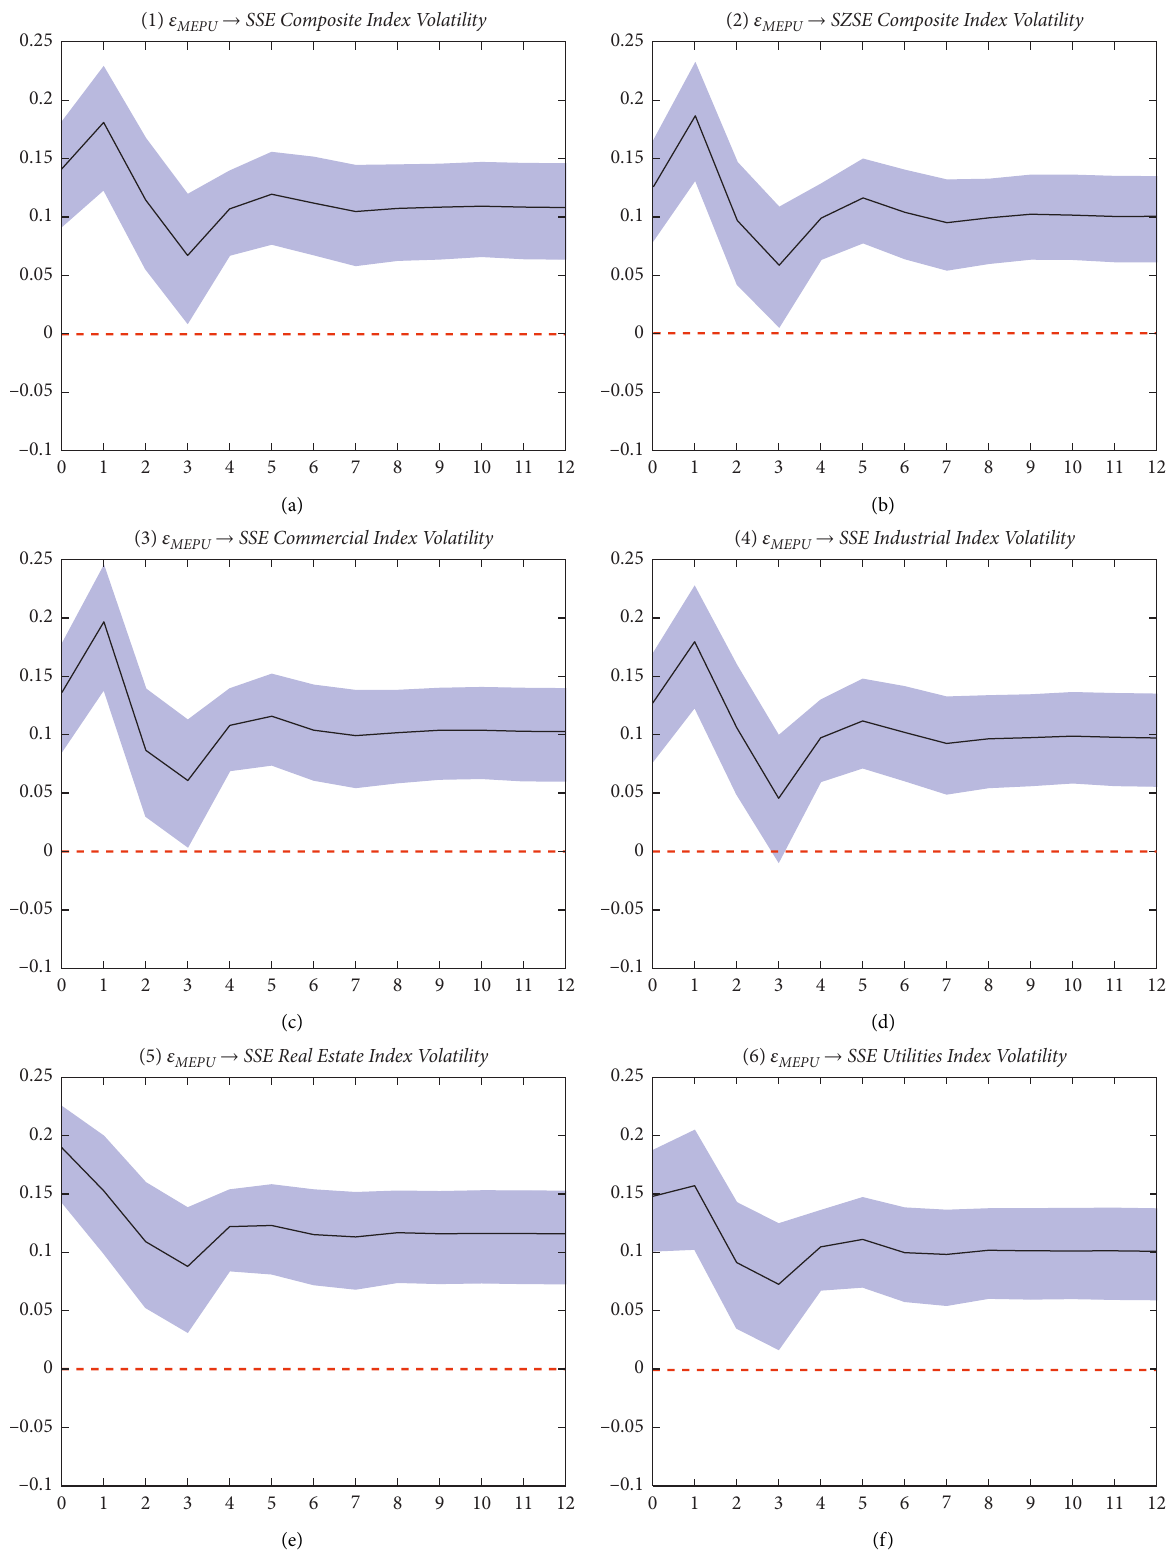
Figure 10: Cumulative impulse response of stock market volatility to monetary EPU (MEPU) shocks Notes: the solid black lines denote the median impulse response. The light-colored region represents 68% of error bands. Each period is a